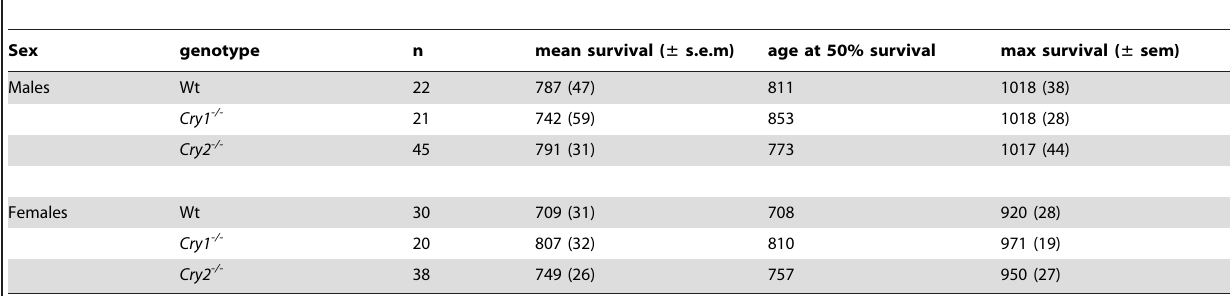
Table 1. Characteristic of survival (in days) in male and female wild type (Wt), Cry1 deficient ( Cry1 -/- ), and Cry2 deficient ( Cry2 -/- )